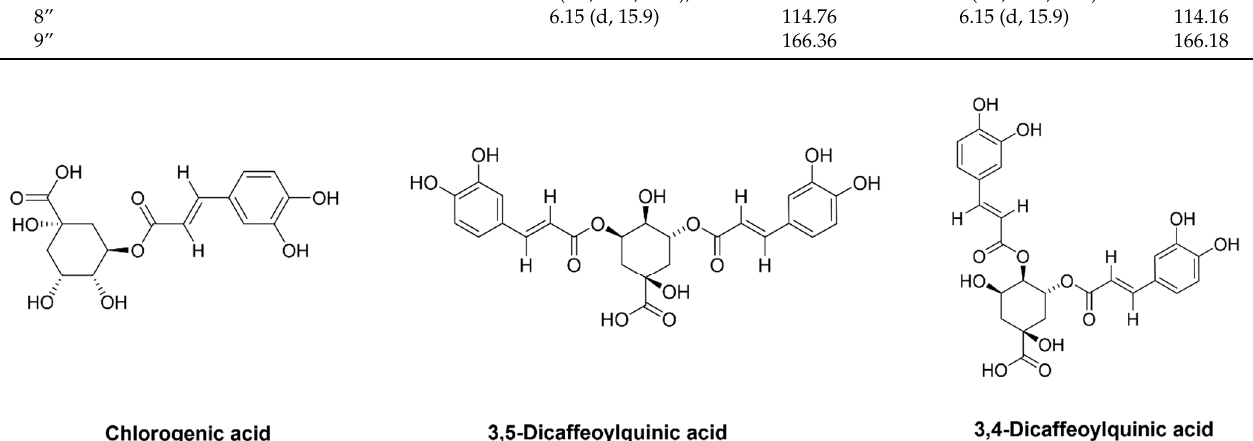
Figure 7. Chemical structures of the isolated compounds from NPR extract. Compound 2 was obtained as a yellow amorphous powder. The 1 H NMR and 13